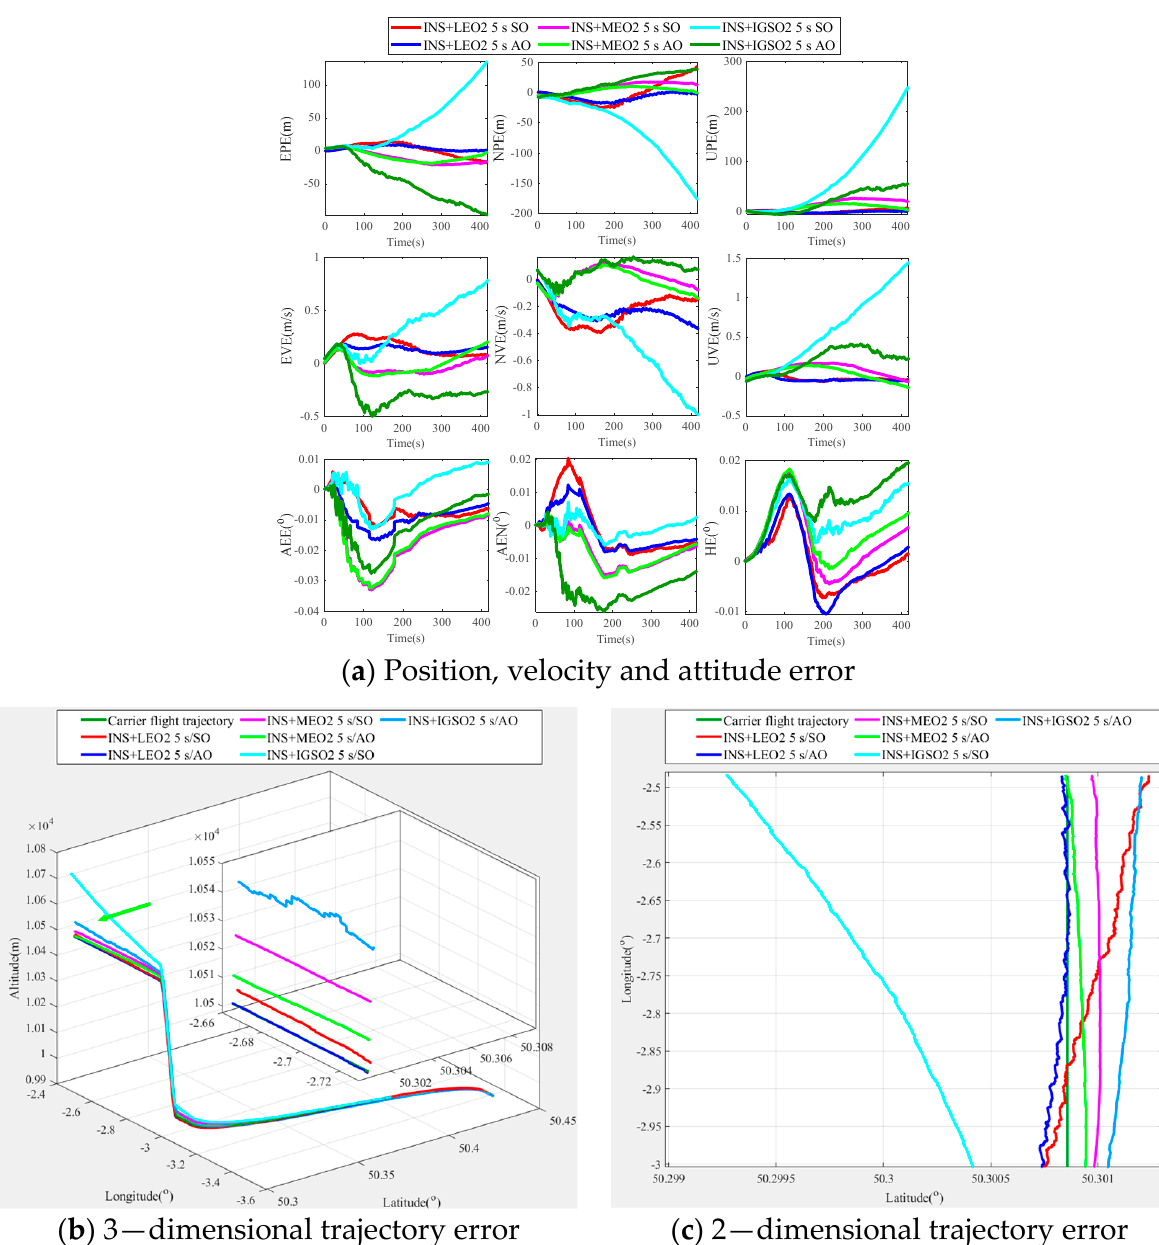
Figure 8. Comparison curve between the INS+LEO2-satellite 5 s alternate switching ranging algorithm and INS+MEO2- satellite 5 s alternate switching algorithm.